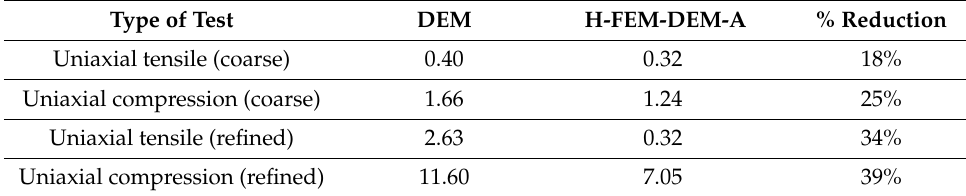
Table 2. Execution times (hours) for uniaxial compression and tensile tests.